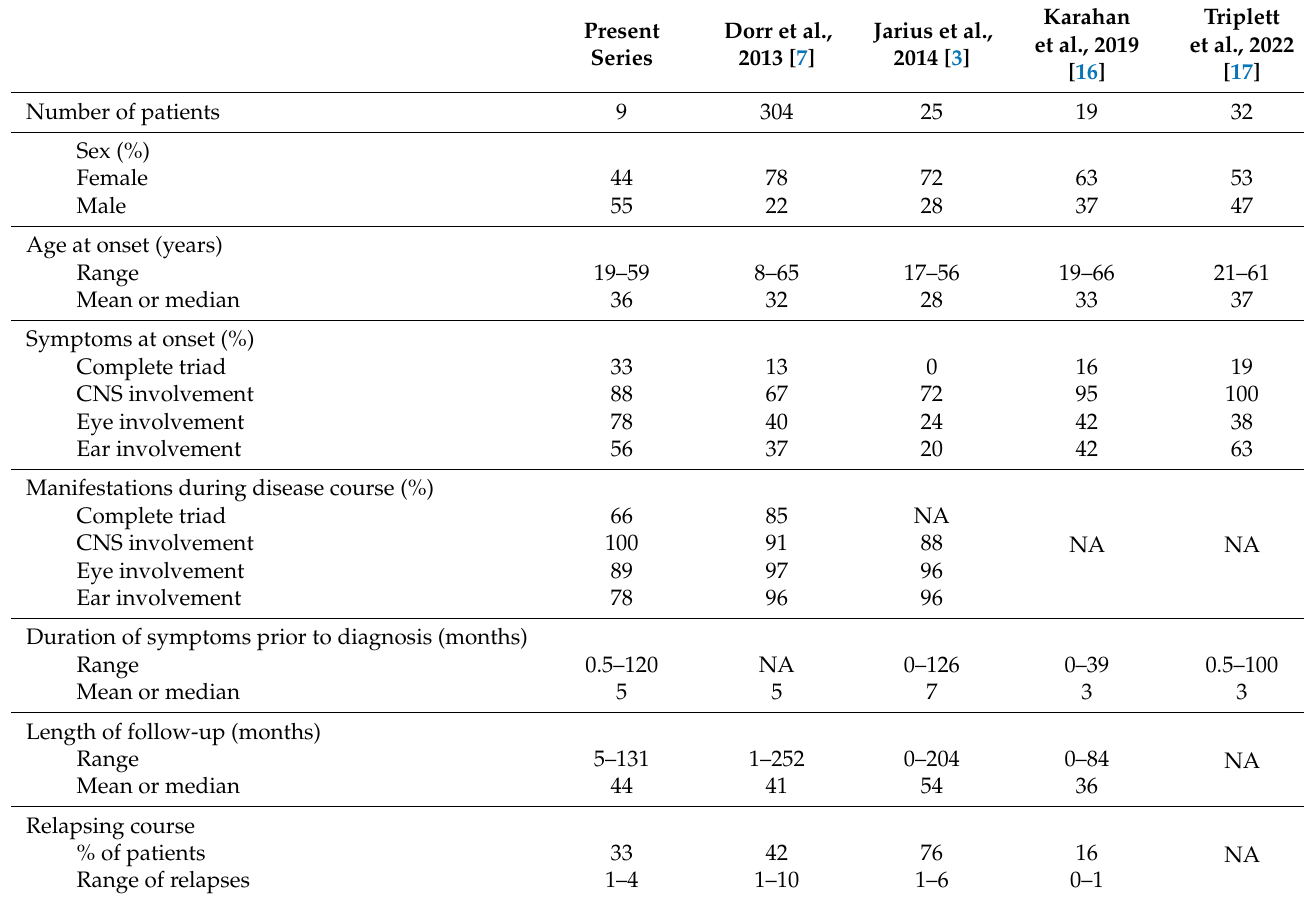
Table 4. Comparison of patient characteristics of the present series with previous published SS series or cohorts. Present Dorr et al., Jarius et Series